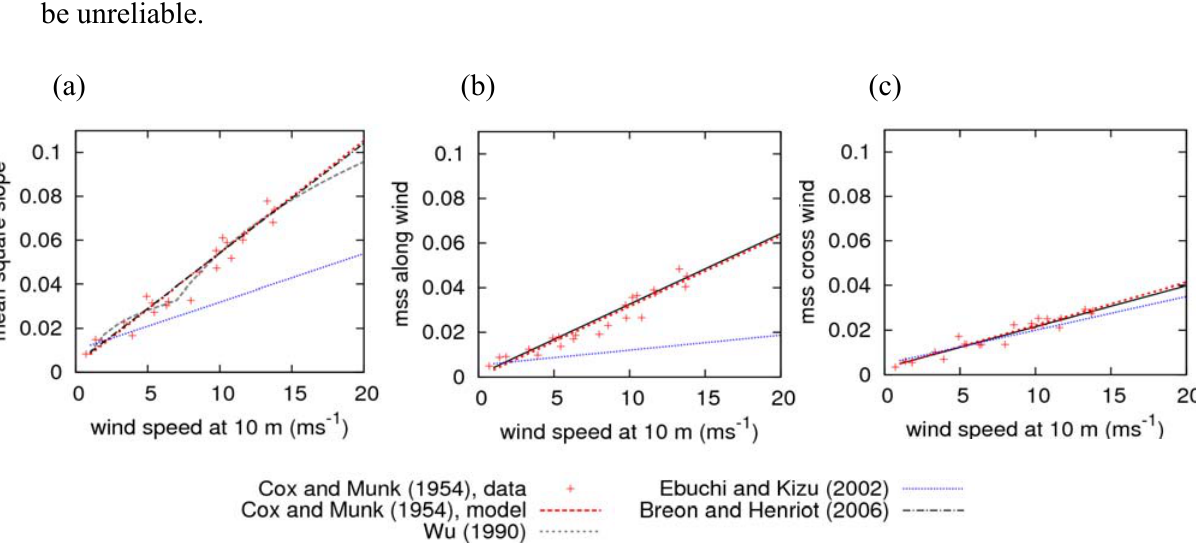
Figure 4. Mean square slopes of the sea surface plotted against wind speed for the Cox and Munk data and for the models of Cox and Munk [5], Wu [46] (overall mss only), Ebuchi & Kizu [48] and Breon & Henriot [49]. (a) overall mean square slope (b) along the wind direction (c) crosswind. All data are for clean surfaces, not slicks. Note that the Cox and Munk wind measurements were actually made at 12.5 m rather than 10 m, and that Cox and Munk’s data point at U = 0.89 ms − 1 is omitted because they considered it to be